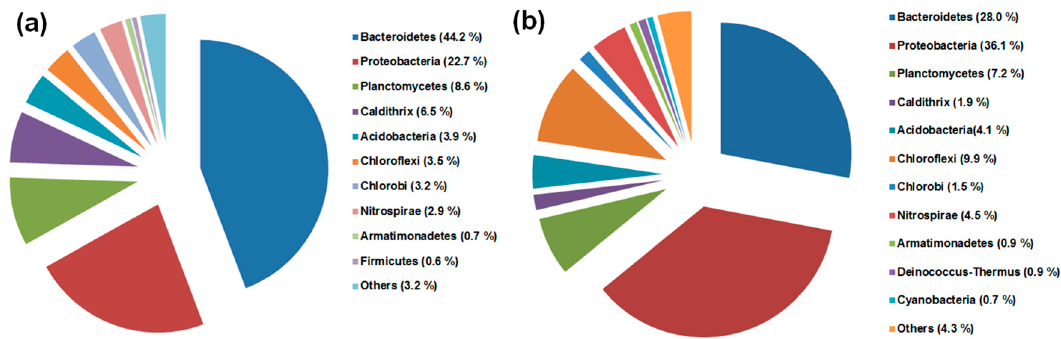
Figure 4. Phylum distribution of microbial communities. Minor phyla less than 0.5% of total sequences are grouped as “others”. ( a ) Mixed liquor from domestic wastewater (DWW); and ( b ) mixed liquor from hospital wastewater (HWW) in the hospital wastewater treatment plant.